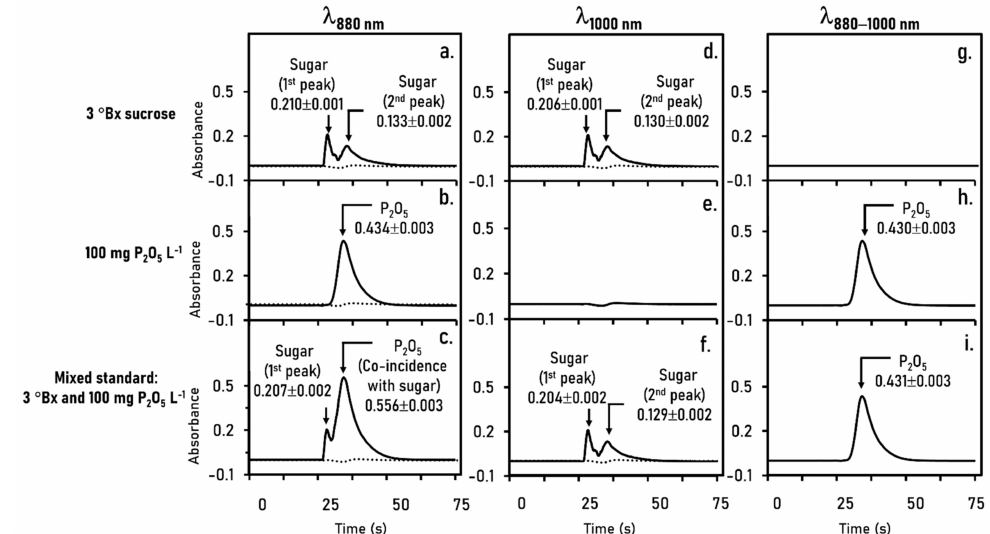
Figure 4. Compensation of the schlieren effect for orthophosphate analysis. The flow profiles obtained when) standard solution of 3 ◦ Bx sucrose ( a , d , g ), 100 mg P 2 O 5 L − 1 ( b , e , h ) and mixed standard ( c , f , i ) as plug S in zone sequence in Figure 1c, operated by the SIA system in Figure 1a. A 880 : absorbance at analytical wavelength; A 1000 : absorbance at reference wavelength; A 880 − 1000 : corrected absorbance. Dashed line indicating the reagent blank signal. Numbers presenting the mean ± standard deviation of absorbance values obtained from triplicate cycle